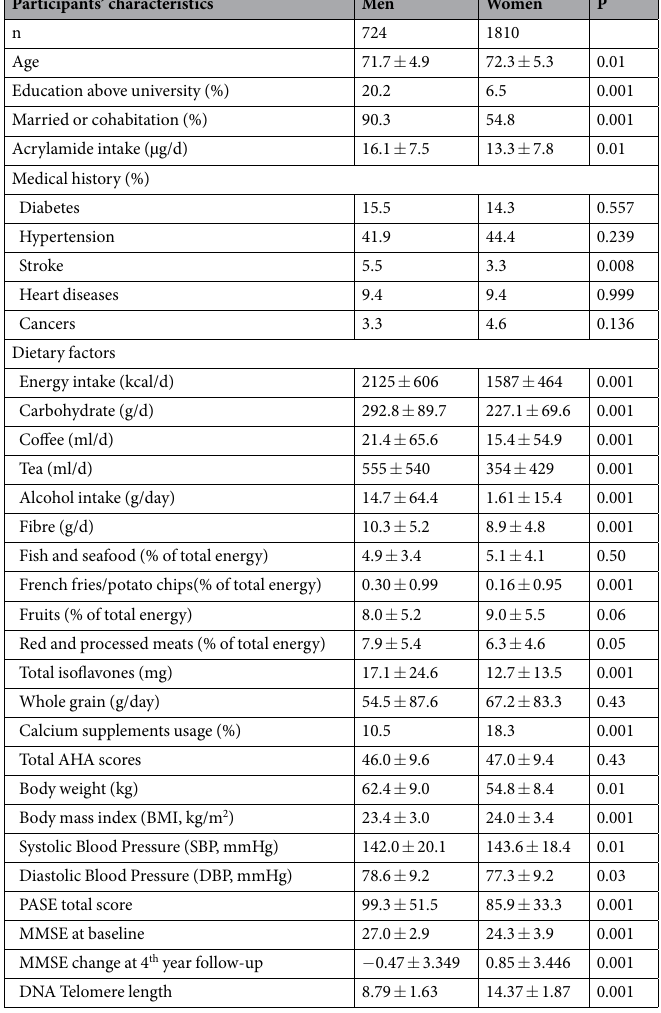
Table 1. Participants’ characteristics among non-smoking Chinese elderly men and women. Data were presented as mean ± SD or number (%). Independent t-test and Chi-square test were used for continuous and categorical variables, respectively. PASE: Physical Activity Scale for the Elderly; Total AHA scores were estimated based on the adherence index of American Heart Association on dietary and life style recommendations. MMSE: questionnaire for Mini-Mental State